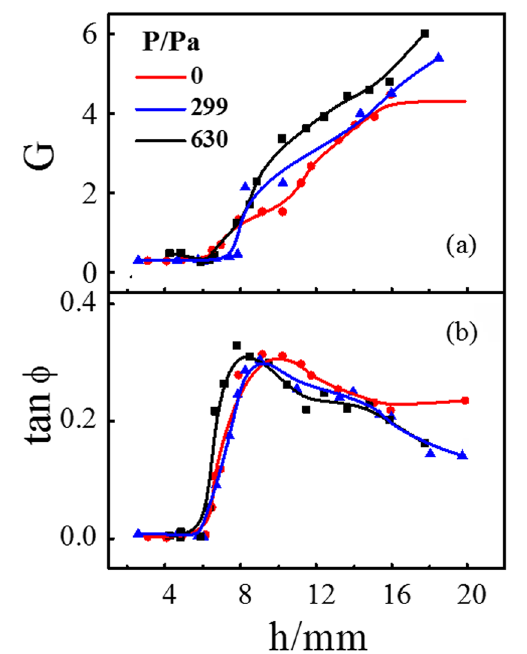
Fig. 6. Schematic of the evolution of strain chain of glass beads with increasing shear amplitude or immersed depth of the probe (ε and ε is the critical shear amplitude or immersed min max